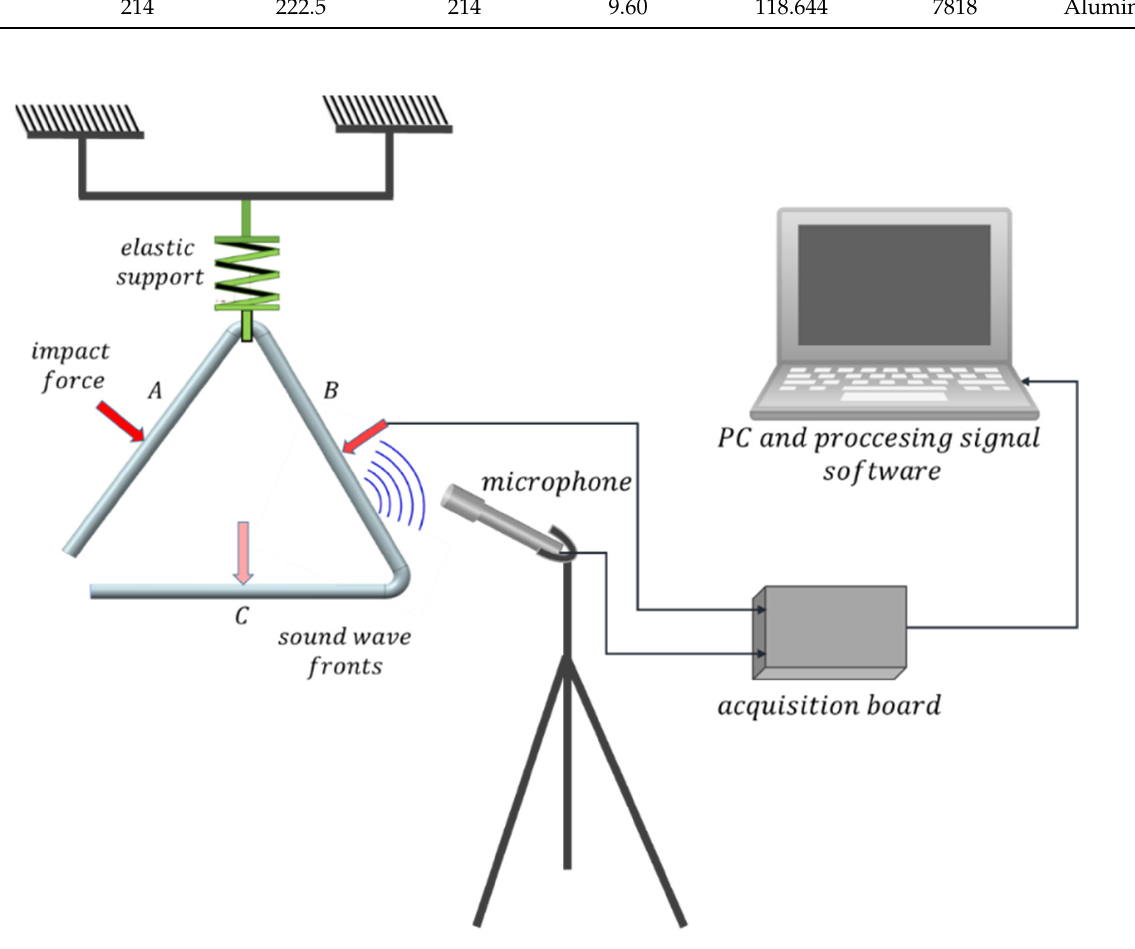
Figure 2. Experimental setup (Legend: A—denotes the first side that was hit with the impact hammer; B—represents the side between the two open sides of the triangle; C—represents the third side of the triangle).